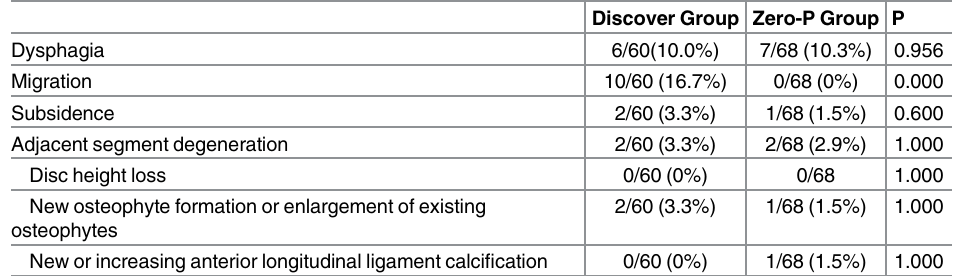
Table 4. Dysphagia, prothesis migration, subsidence and adjacent segment degeneration of patients between the 2